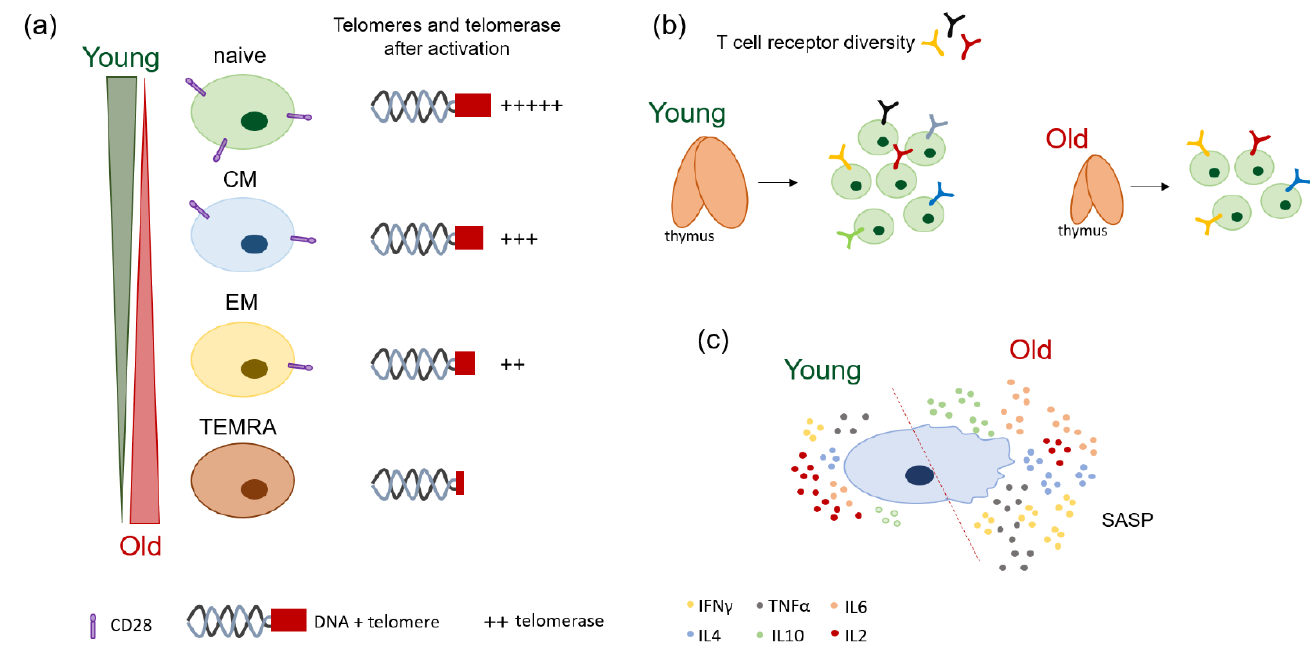
Figure 1. Schematic representation of age-related changes in T cells. ( a ) Accumulation of memory T cells lacking CD28 co-stimulatory molecules and with defects in telomeres and telomerase activity is predominant in the elderly. ( b ) Thymus involution is a hallmark of aging, and it reduces TCR diversity and T cell clonality. ( c ) Aging leads to senescence-associated secretory phenotype (SASP) induction in T cells.